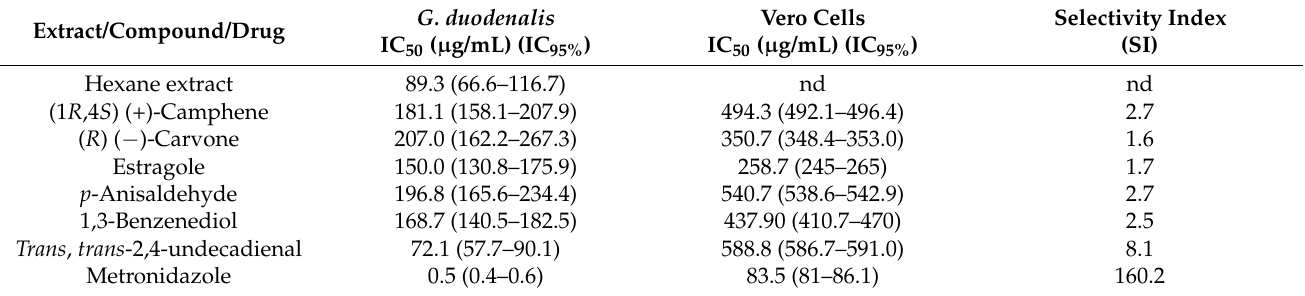
Table 2. Antigiardial and cytotoxic activities of F. vulgare hexane and some of its